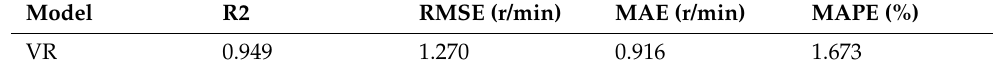
Table 3. The prediction accuracy of the shaft speed prediction model on the test set.